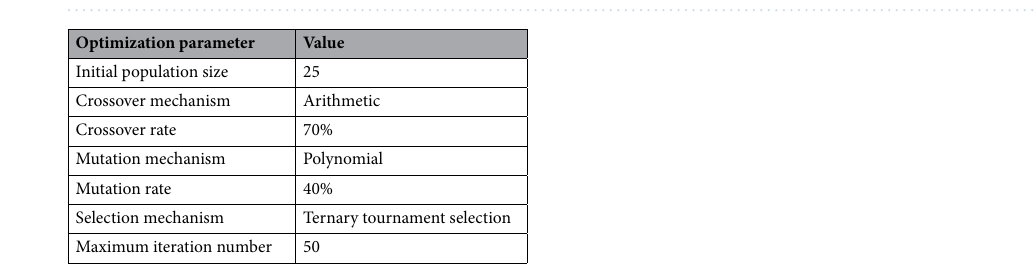
Figure 3. Typical transfer functions ( a ) Logsig, ( b ) Tansig, and ( c ) Pureline.